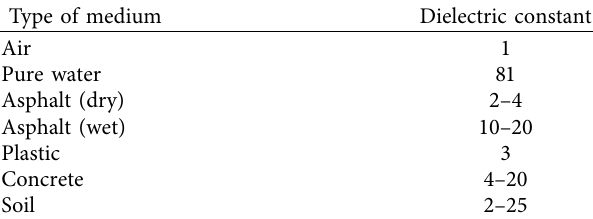
Table 1: Dielectric constants of common media.